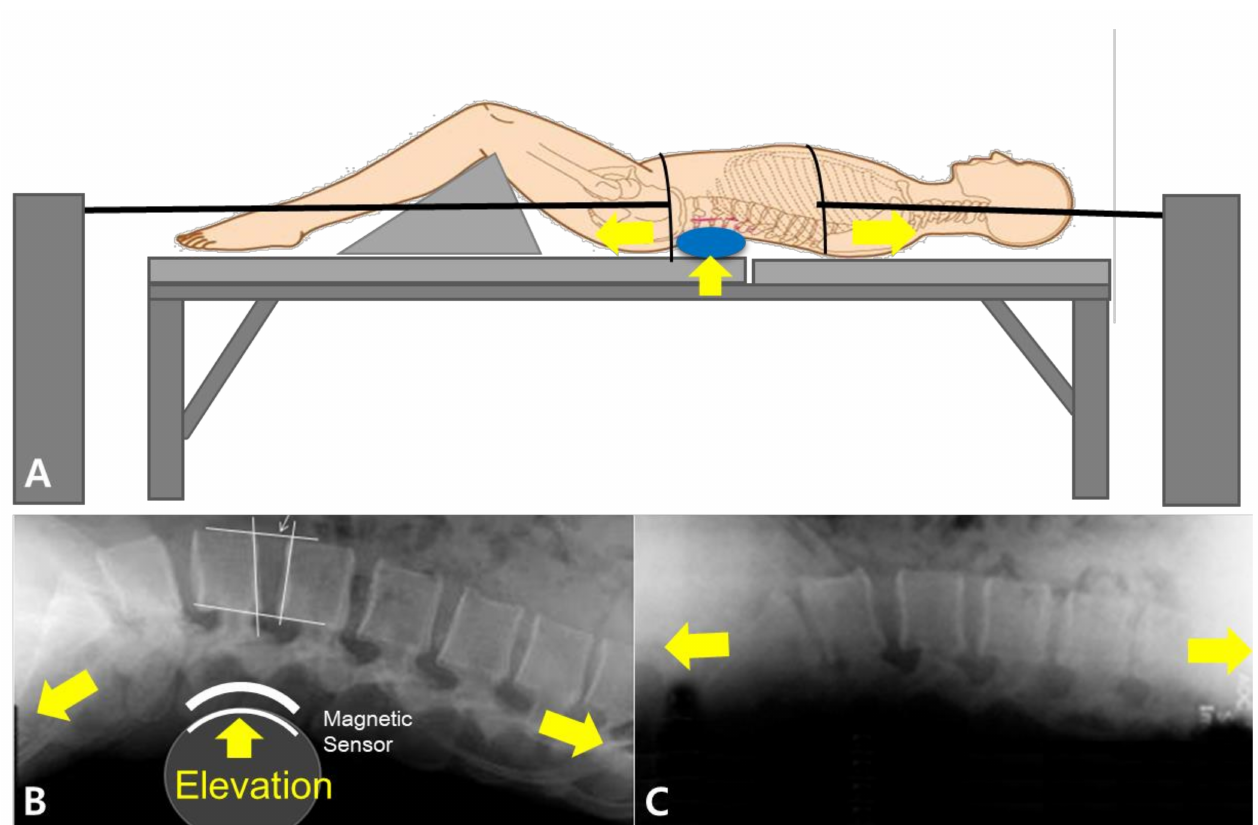
Figure 1. Lumbar traction techniques: ( A , B ), lumbar lordotic curve-controlled traction (LCCT) and ( C ), standard spinal traction (ST). The LCCT maintains the lordotic curve of the spine during traction by elevating the lordotic curve